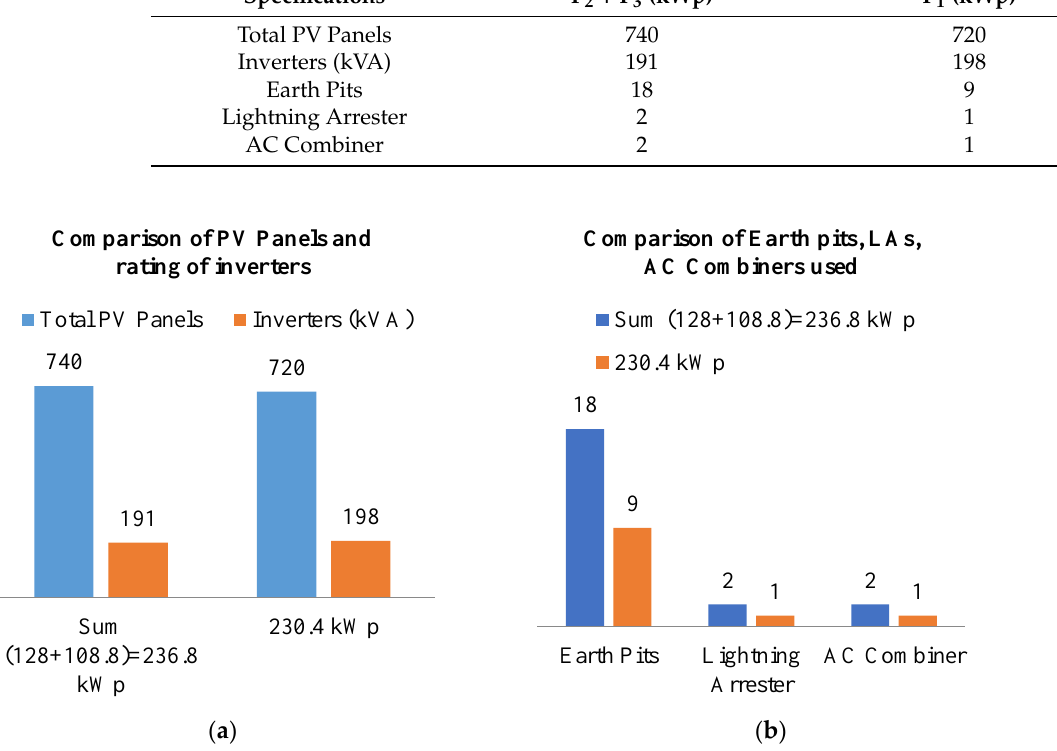
Table 4. Comparison of required electrical appliances in Plant ‘P 2 + P 3 ’ and Plant ‘P 1 ’.